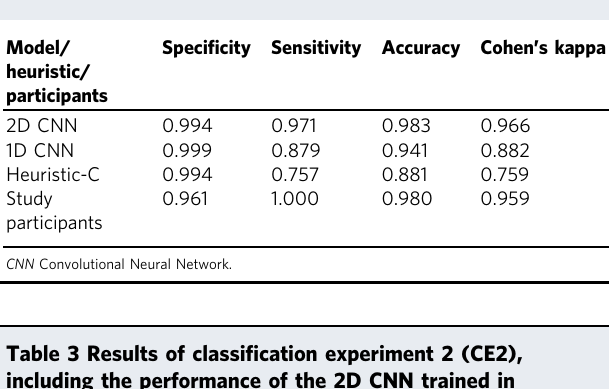
Table 2 Results of classi fi cation experiment 1 (CE1) ( N = 294, dataset 3 ’ s test dataset with fewer weak positive results).